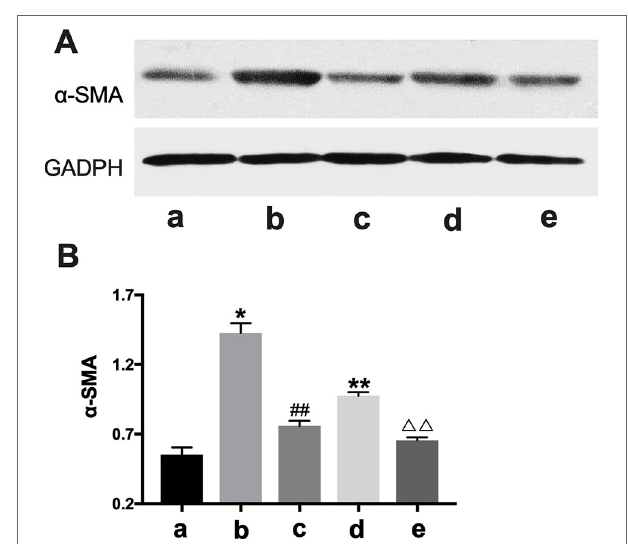
FIGURE 7 | Western blot analysis of α -SMA expression. CTGF, connective tissue growth factor. BXYS, Buxin Yishen decoction. CHF, chronic heart failure. α -SMA : alpha smooth muscle actin. a: BLANK group. b: BLANK+CTGF group. c: CTGF+BXYS group. d: CHF group. e: CHF+BXYS group. *P < 0.05, **P < 0.01 vs. BLANK group. ## P < 0.01 vs. BLANK+CTGF group. ΔΔ P < 0.01 vs. CHF group. (A) α -SMA expression in cells. (B) Quantitative analysis of western